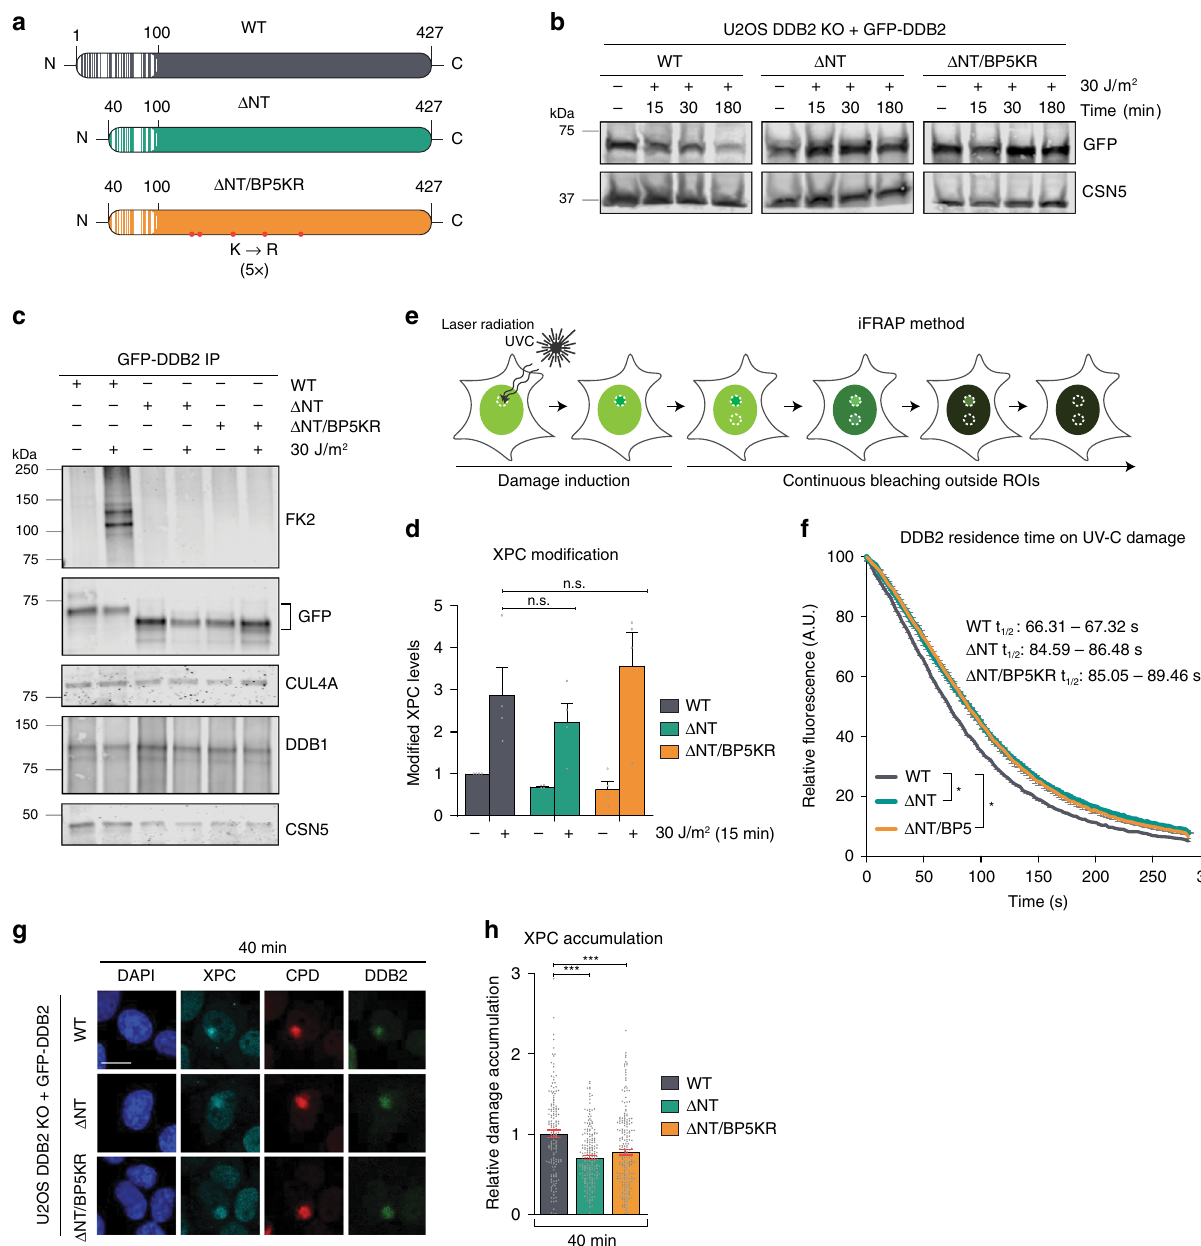
Fig. 6 DDB2 ubiquitylation facilitates its damage extraction to promote damage handover to XPC. a Overview of DDB2 wild-type (WT, 427 amino